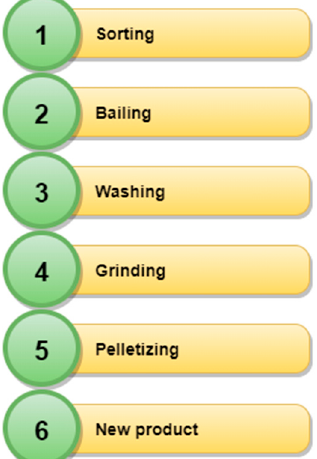
(Figure 4): sorting, bailing, washing, shredding, pelleting, and the production of a new